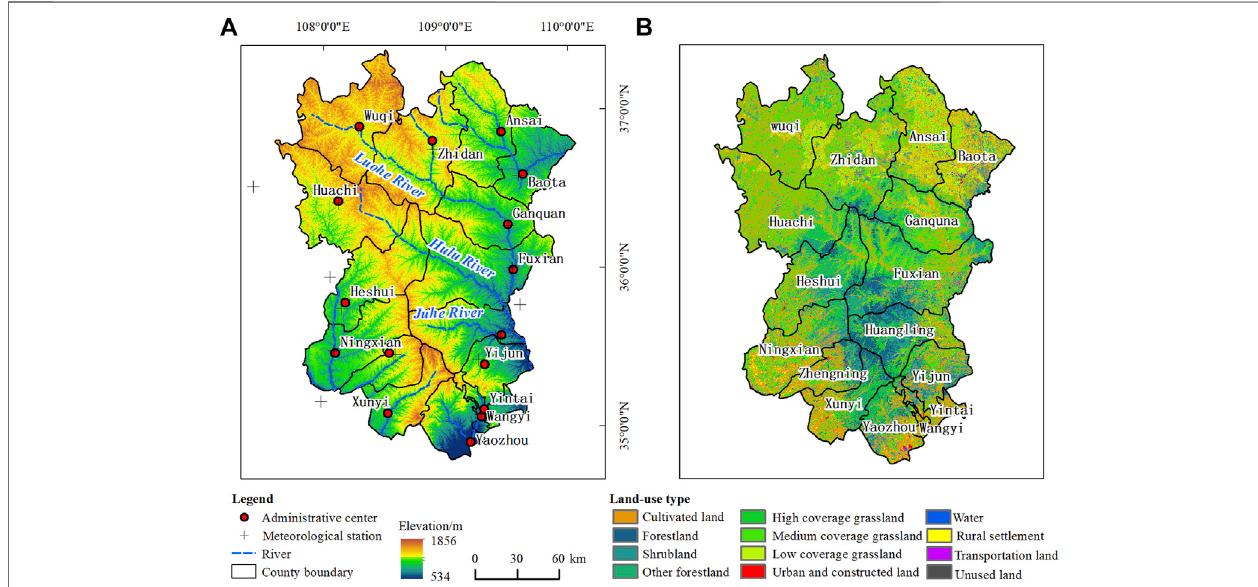
FIGURE 2 | Location of the Ziwuling Mountainous Region (ZMR) (A) and land-use map in 2017 (B) .